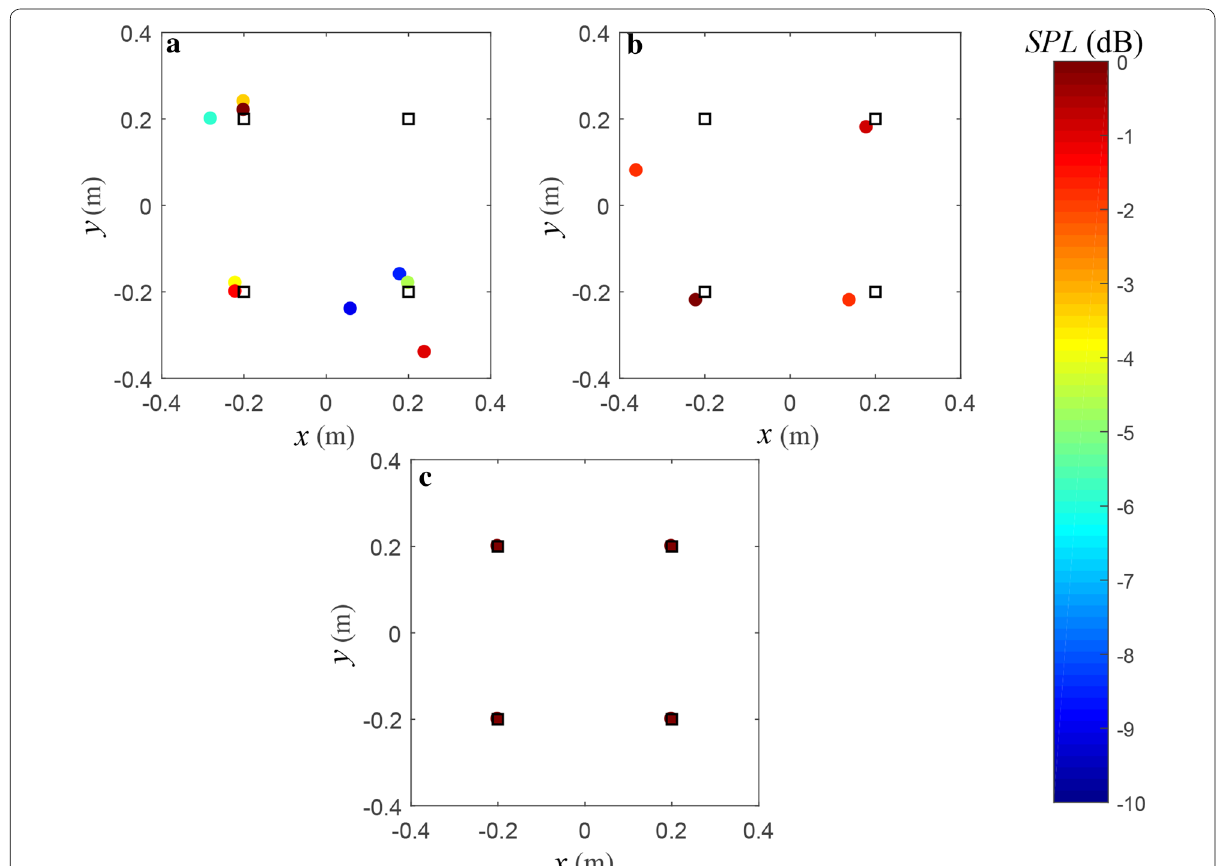
Figure 6 Source maps and the CPU-time obtained by: a Wideband BP method (126.3 s), b DCS-SOMP method (1.342 s), c DCS-SOMP-SVD method (2.473 s) when the SNR equals 10 −